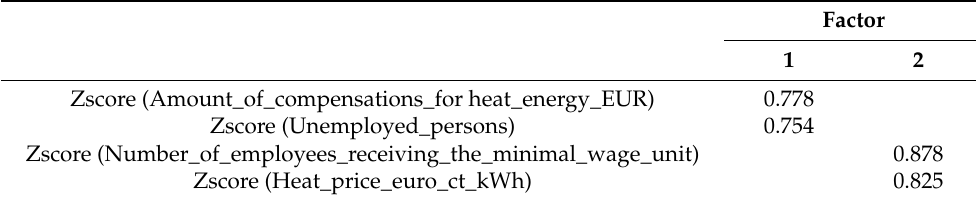
Table 8. Importance results of the shadow economy risk